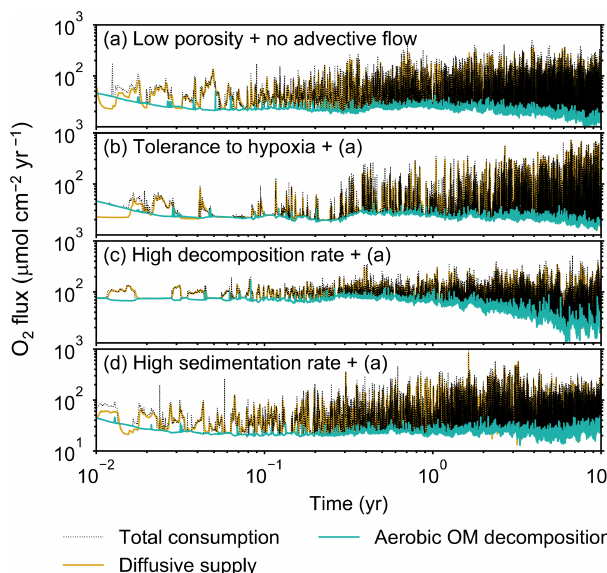
Figure 9. Time evolution of oxygen fluxes obtained from 10-year simulations with eLABS. See Sect. 3.2 and caption of Fig. 8 for the details of simulations (a–d) . Black dotted curves represent the to- tal oxygen consumption fluxes, orange curves the fluxes of oxygen supply via molecular plus eddy diffusion, and turquoise curves the oxygen consumption fluxes through aerobic degradation of organic